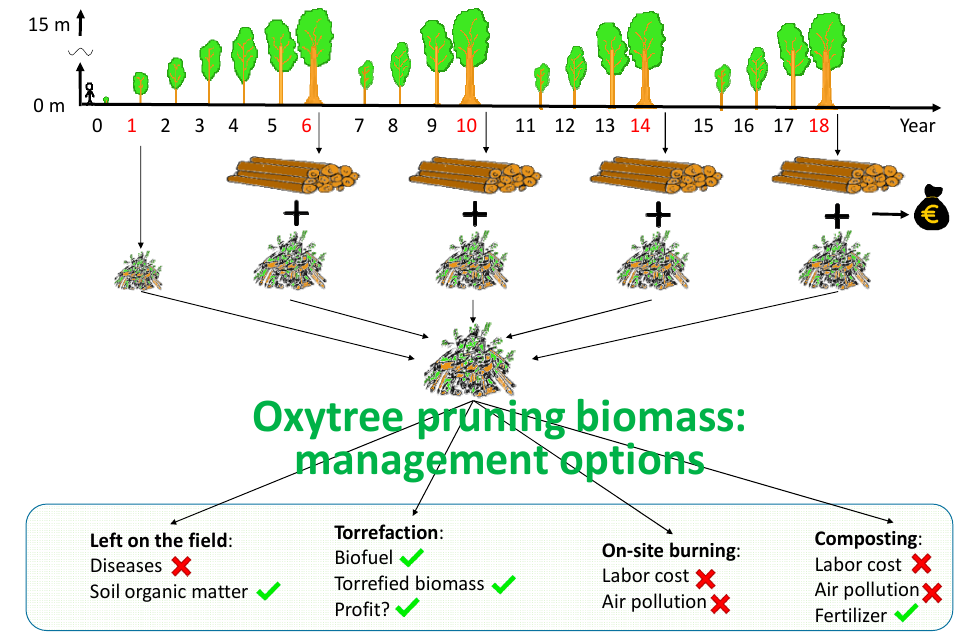
Figure 1. Graphic presentation of the current and proposed utilization of biomass residues on a plantation.